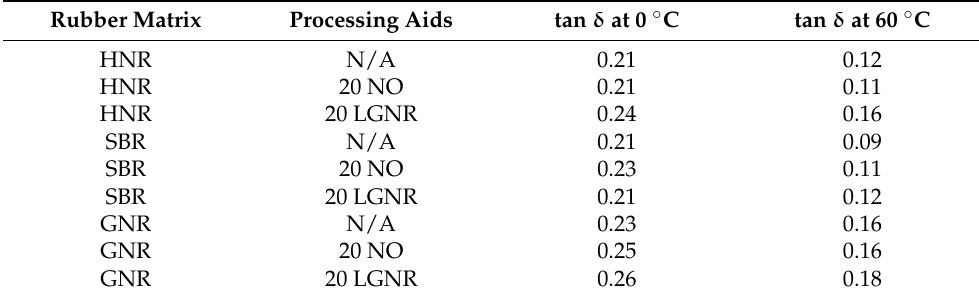
Table 4. The t an δ of rubber composites at 0 and 60 °C. N/A: rubber compounds without processing aids; 20 NO: rubber compounds with 20 phr naphthenic oil; 20 LGNR: rubber compounds with 20 phr liquid guayule natural rubber.